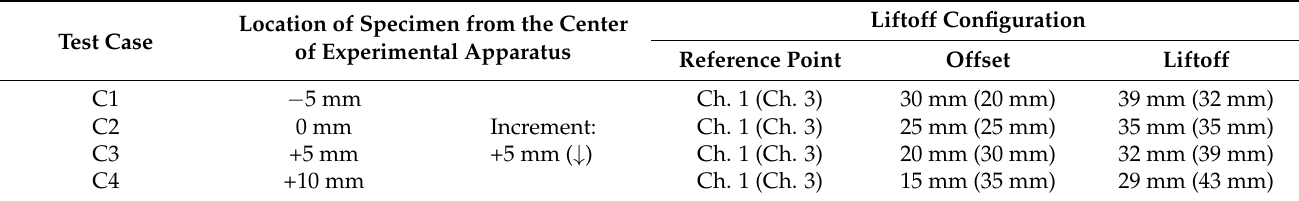
Table 3. Liftoff configurations in the vertical axis direction ( z